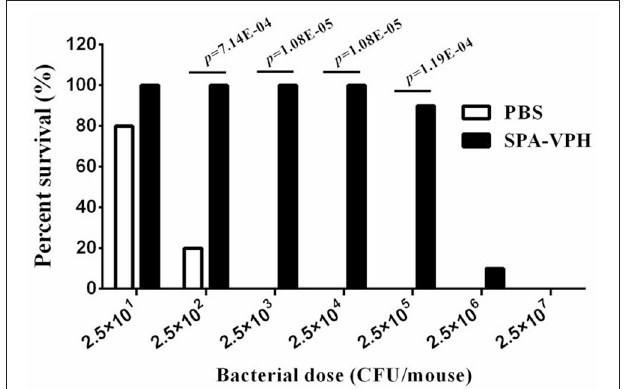
FIGURE 7 | Immunoprotection by nasal vaccination with SPA-VPH in BALB/c mice against challenge of Salmonella enterica serovar Typhi Ty2. BALB/c mice were nasally administered with SPA-VPH at 2.0 × 10 9 CFU/mouse, or PBS as control. On the 30 day postvaccination, immunized mice were intraperitoneally challenged with 10-fold diluted bacterial suspensions of S . Typhi Ty2 from 2.5 × 10 1 to 2.5 × 10 7 CFU suspended in 10% gastric mucin. PBS-immunized mice were challenged at doses from 2.5 × 10 1 to 2.5 × 10 4 CFU per mouse. After challenges, deaths of mice were monitored within 72 h. Survival percent of PBS-immunized mice at challenging doses from 2.5 × 10 5 to 2.5 × 10 7 are regarded as